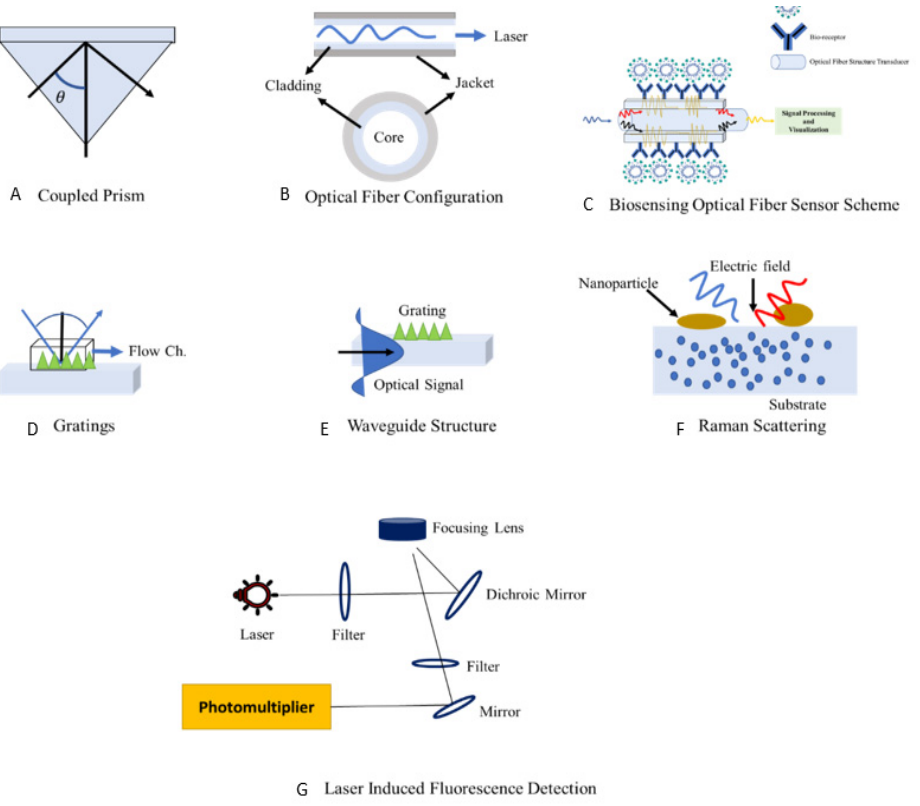
Figure 3. Block diagram of latest COVID-19 detection technologies structures: surface plasmon resonance (SPR) configuration ( A–D ); ( E ) bioreceptor fiber optic sensing method; ( F ) surface enhancement Raman scattering, and ( G ) laser-induced fluorescence (LIF) detector.